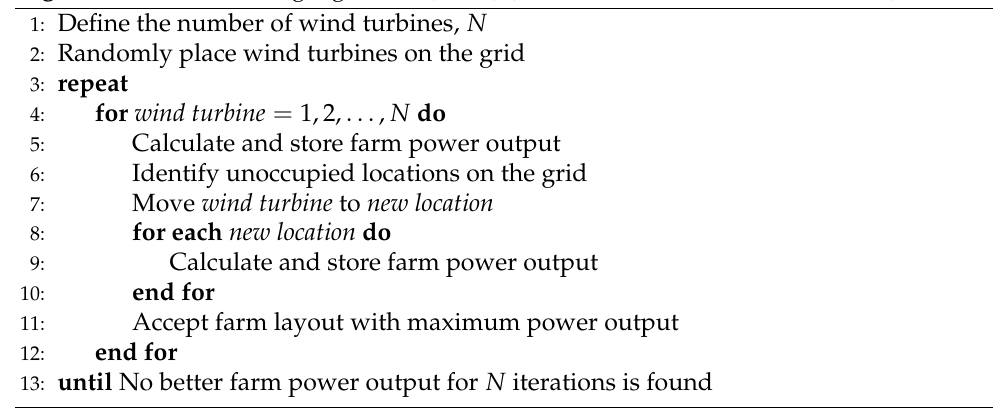
Algorithm 1 Hill-climbing algorithm (HCA) (for fixed number of wind turbines)